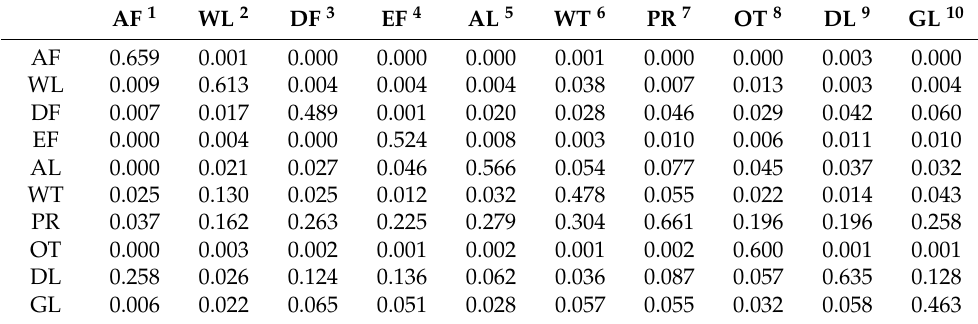
Table 1. Probability of land cover types being adjacent to each other in the Mun River